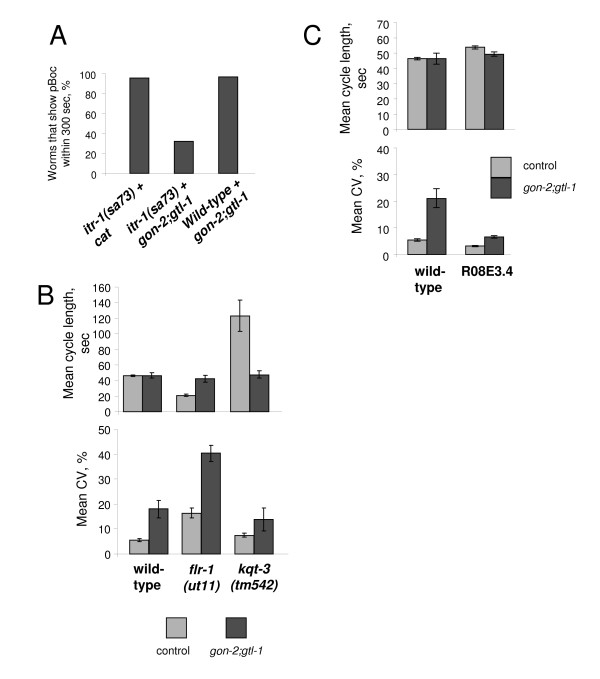
Interactions of gon-2;gtl-1 with itr-1, flr-1, kqt-3 and R08E3.4. A-B: We tested for interaction of gon-2(RNAi);gtl-1(RNAi) with other genes known to be involved in control of the defecation cycle. A: When gon-2 and gtl-1 are knocked down in itr-1(sa73) mutant animals, the cycle is severely disrupted. The percentage of worms which successfully performed one or more pBocs within 300 sec is shown. B: gon-2 and gtl-1 were knocked down in a flr-1(ut11) and kqt-3(tm542) animals. For each genotype we assayed worms that had been injected with dsRNA for the E. coli cat gene (control) and worms injected with dsRNA for gon-2 and gtl-1. The mean cycle length and the mean of the C.V. are shown. C: The increase in variability in gon-2(RNAi);gtl-1(RNAi) animals can be suppressed by RNAi of R08E3.4. R08E3.4 was knocked down using RNAi, in combination with a control (E. coli cat) or gon-2 and gtl-1. The mean cycle length and the mean of the C.V. are shown. Error bars are SEM in all panels.